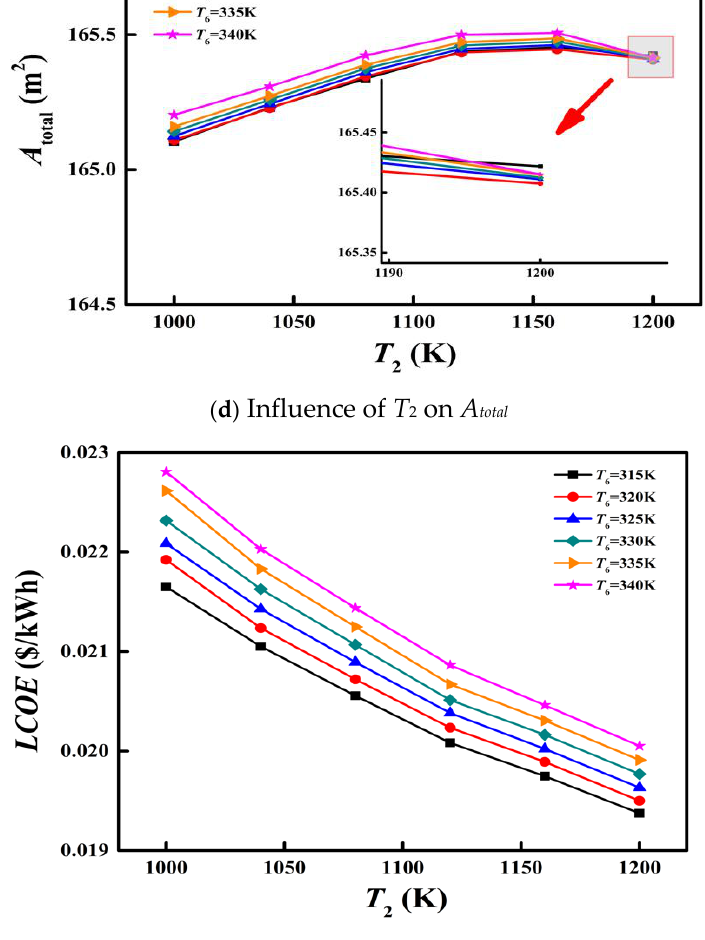
Figure 9. Influence of T 2 on the proposed S-(N 2 O-He) cycle.